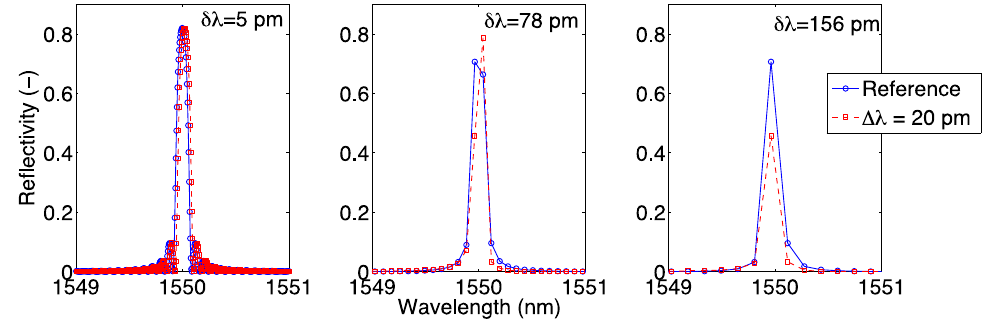
Figure 4. FBG spectra reported in reference condition and for a wavelength shift Δ λ = 20 pm, obtained for different values of wavelength resolution δλ = 5 pm ( left ), δλ = 78 pm ( center ), δλ = 156 pm ( right ).